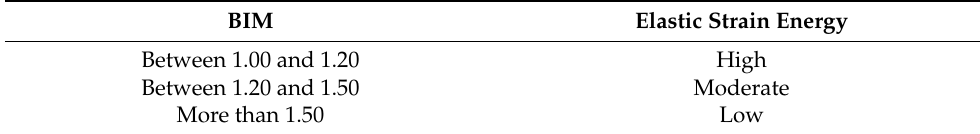
Table 7. BIM indicative values and risk of violent rupture [155]. BIM Elastic Strain Energy